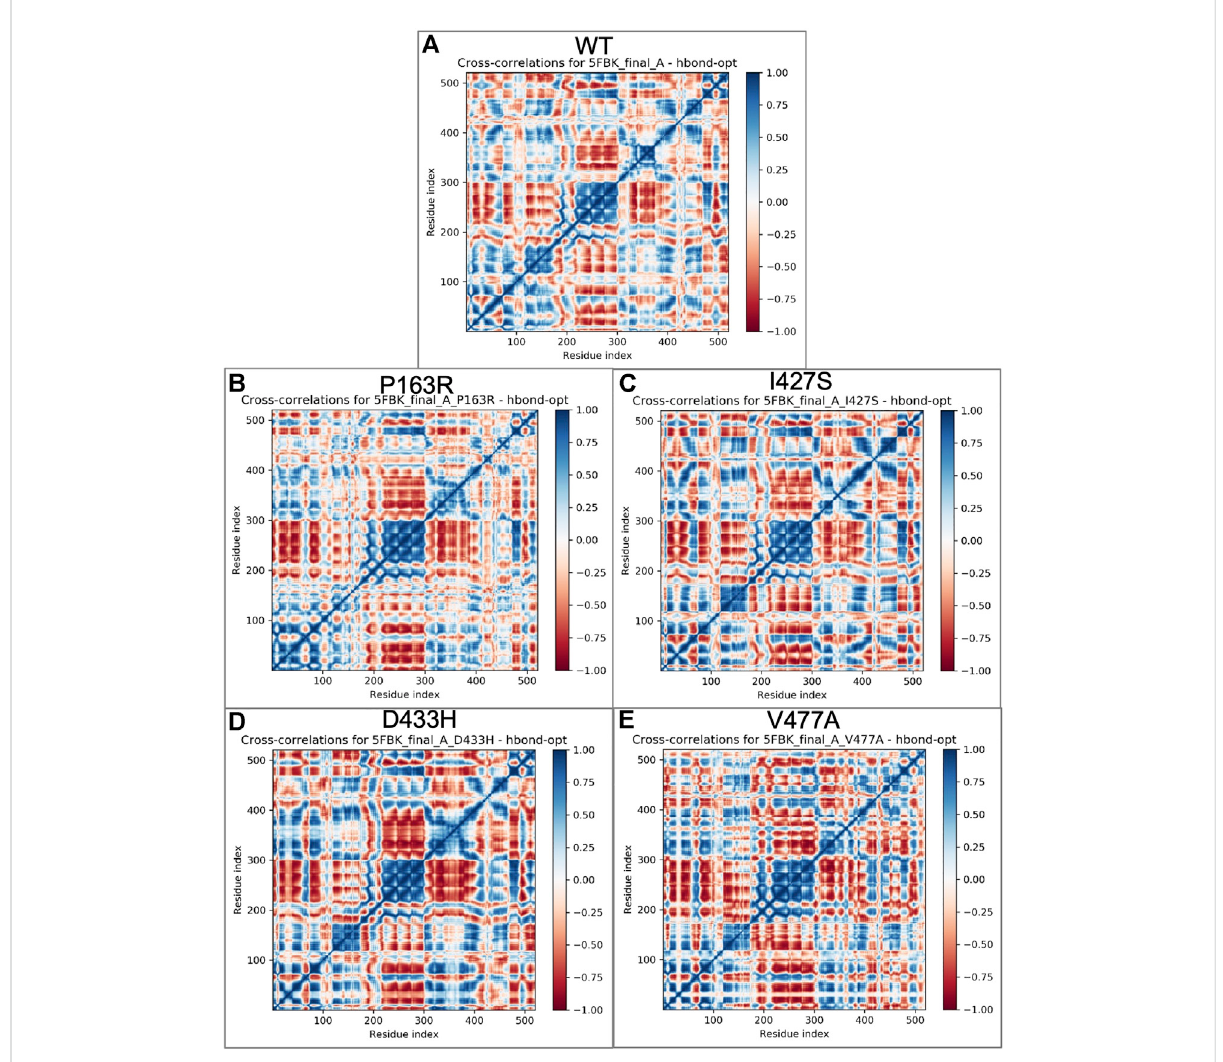
FIGURE 9 Cross correlations matrix obtained from essential dynamics of MD simulation trajectories for individual amino acid of (A) WT, (B) P163R, (C) I427S, (D) D433H, and (E) V477A, respectively. The color gradient represents correlated motion, where blue indicates highly correlated motion, and red indicates negatively correlated